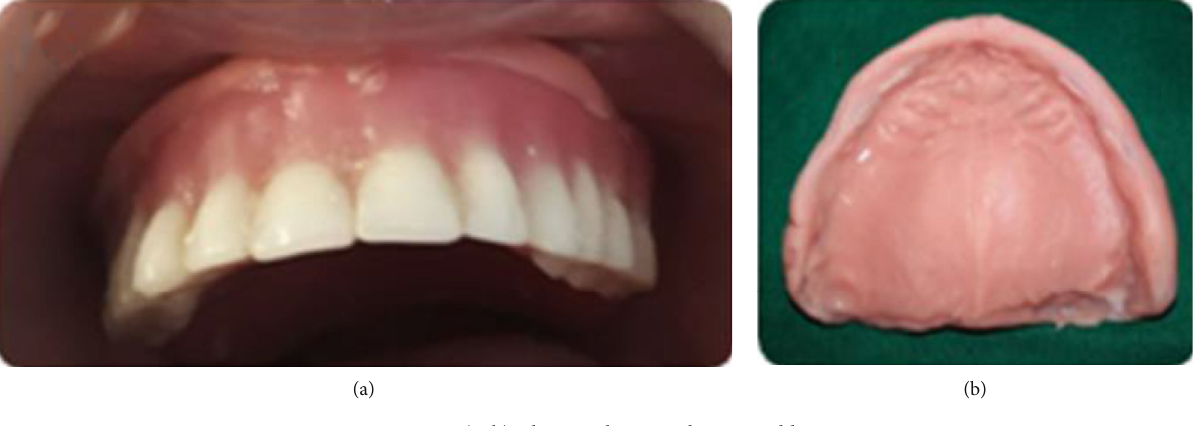
Figure 29: (a, b) Chemopolymerized resin